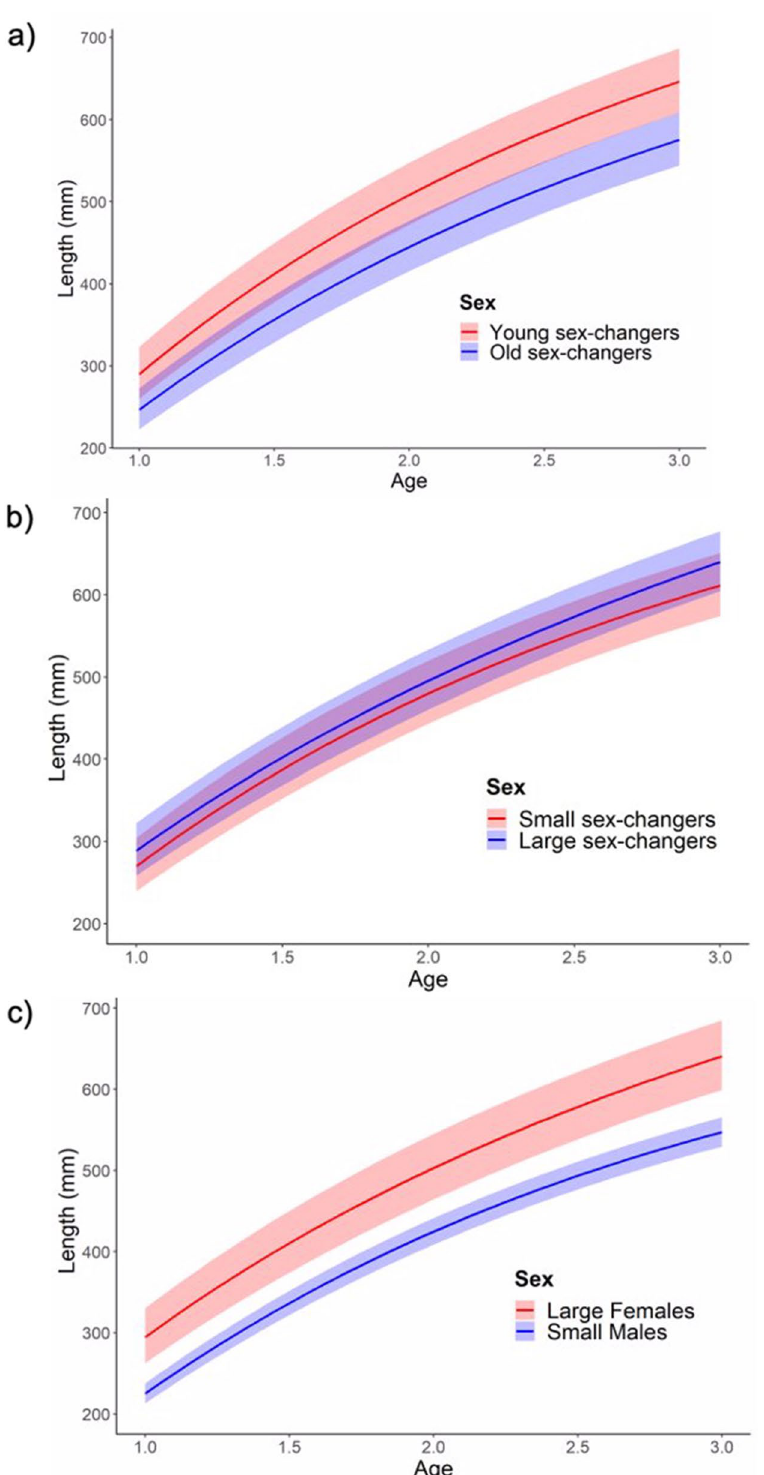
Figure 2. Linear mixed-effects growth curves illustrating differences in size-at-age between different life history types. Blue lines, males; red lines, females. ( a ) old sex-changers and young sex-changers (i.e., effect of growth rate on age of sex change); ( b ) large sex-changers and small sex-changers (i.e., effect of growth rate on size of sex change); ( c ) large females and small males. Shaded areas represent 95% confidence